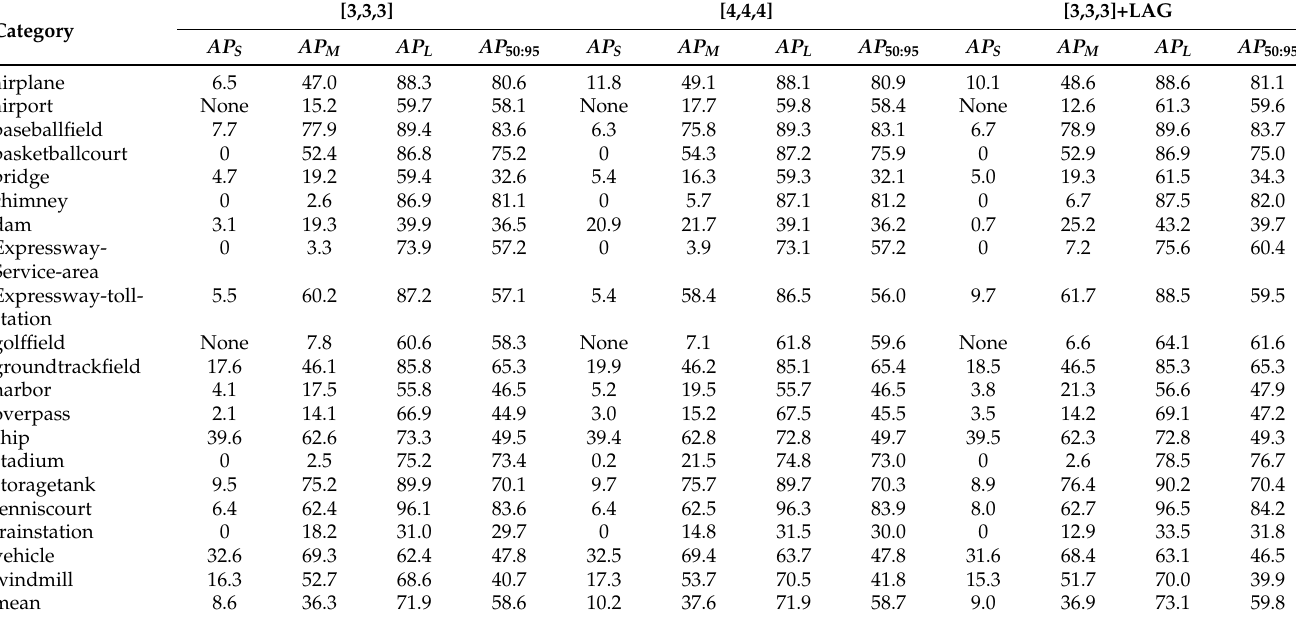
Table 5. The detection performance of each category under different anchor